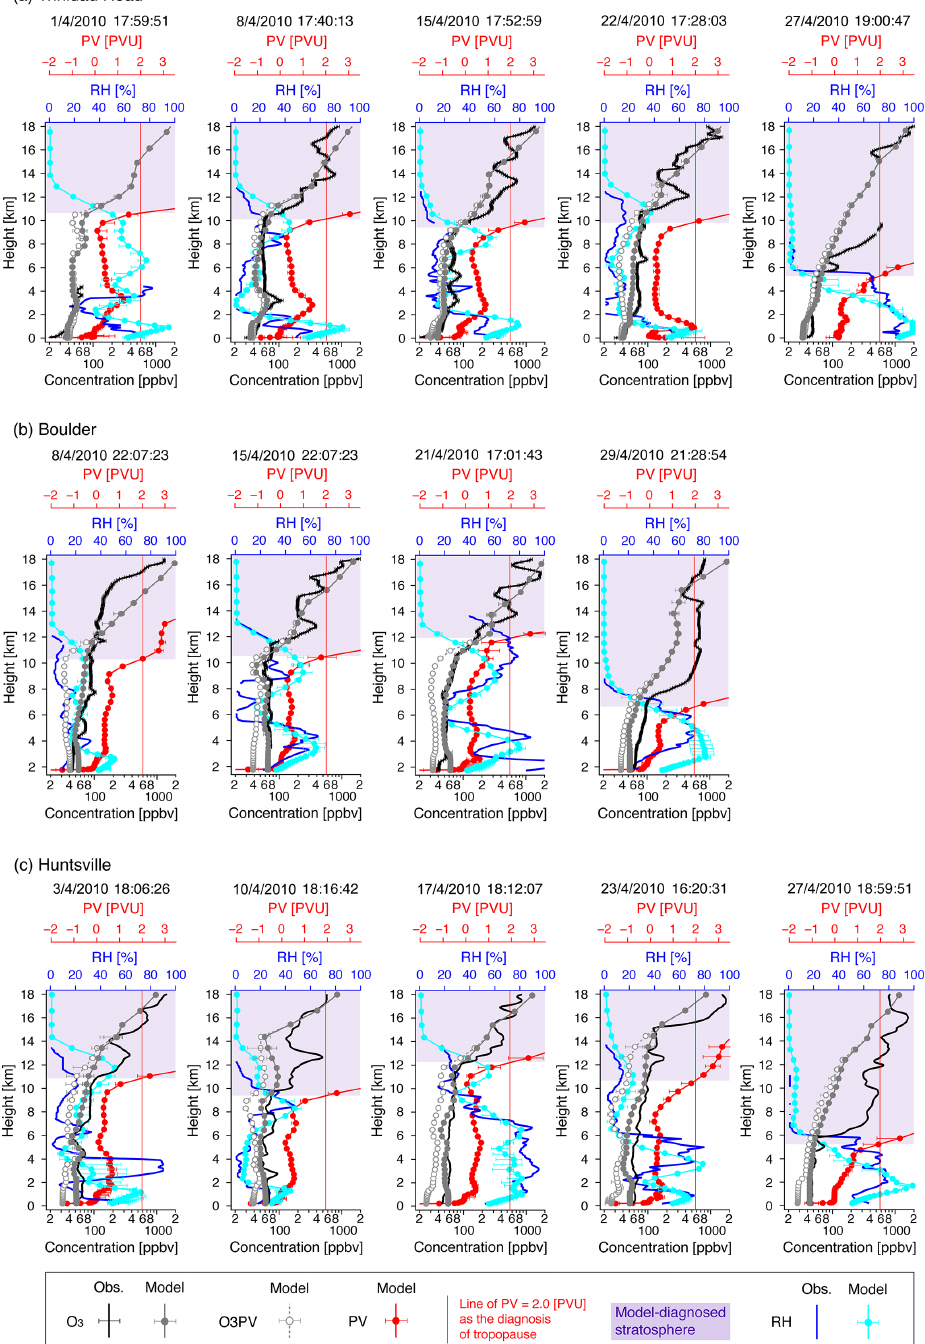
Figure 5. Vertical profiles of observed and modeled O 3 and RH at US ozonesonde sites of (a) Trinidad Head (CA), (b) Boulder (CO), and (c) Huntsville (AL). Also see Fig. 4 for ozonesonde measurement times. For modeled O 3 and RH, the hourly result corresponding to the ozonesonde measurement time is shown by circles, and the maximum and minimum model results within ± 2h of the measurement time are shown by whiskers. For observed O 3 at Hilo and Boulder, the range of uncertainties of the O 3 observations is shown by whiskers. Modeled O3PV and PV are also shown. Modeled PV profiles are plotted in red, and vertical lines corresponding to a PV value of 2 PVU are inserted as an index of the tropopause, and the layer range diagnosed as stratospheric air mass is colored in